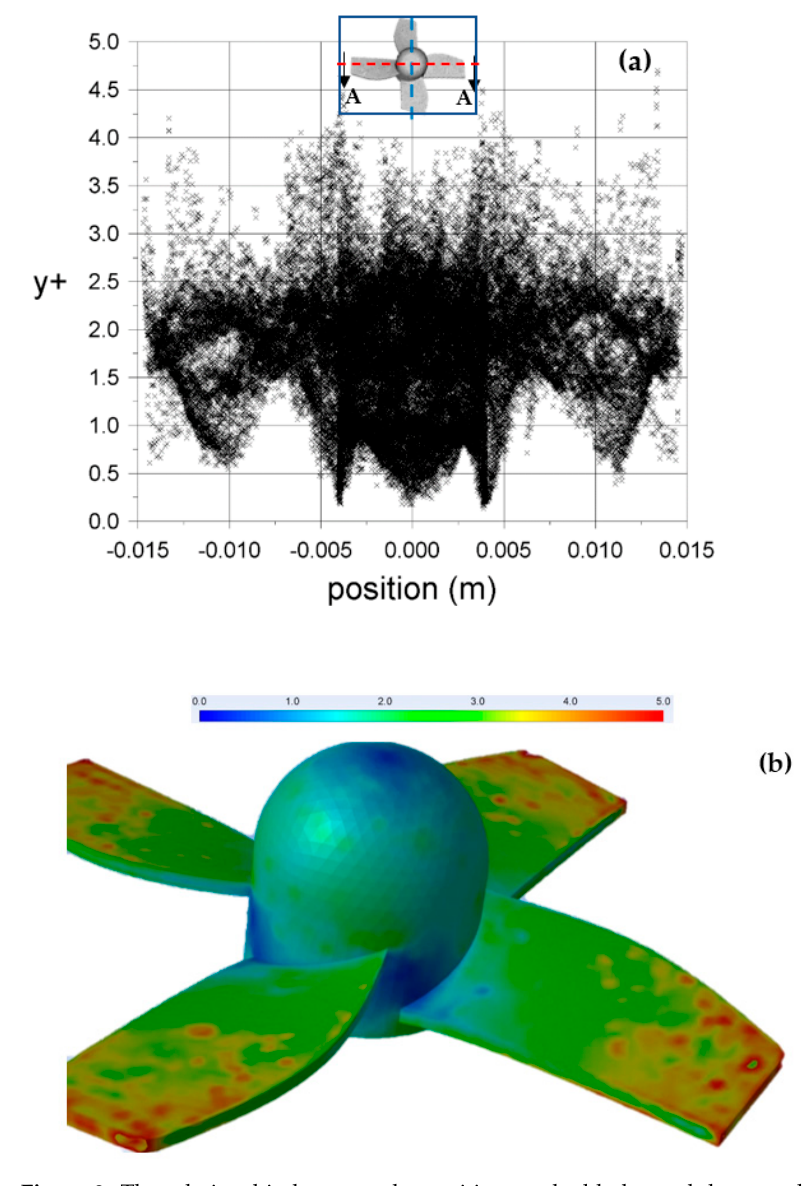
Figure 9. The relationship between the position on the blades and the y+ value at the maximum angular velocity. ( a ) Spatial variations of the wall y+ value along transect A-A, ( b ) Color contours of y+ over the whole rotor.